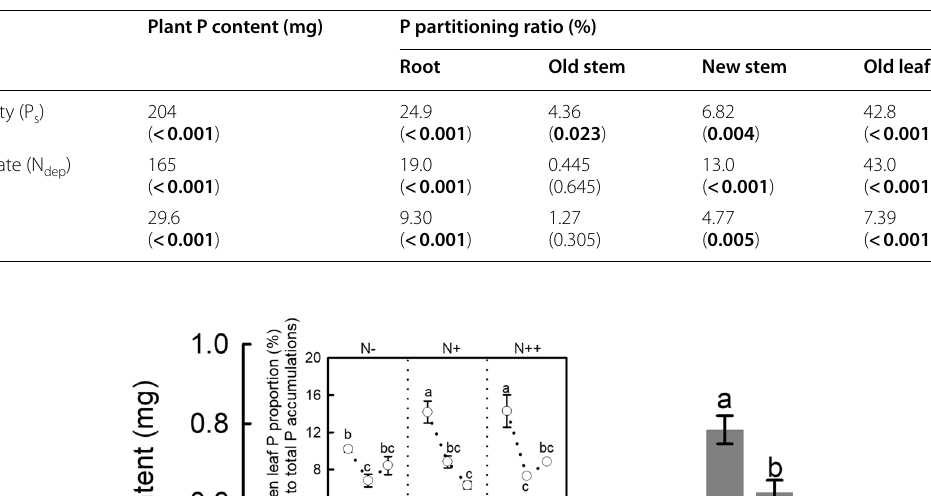
Table 4 Effects of soil P availability (P seedlings and P partitioning ratio ( n ( P < 0.05) are highlighted in bold text